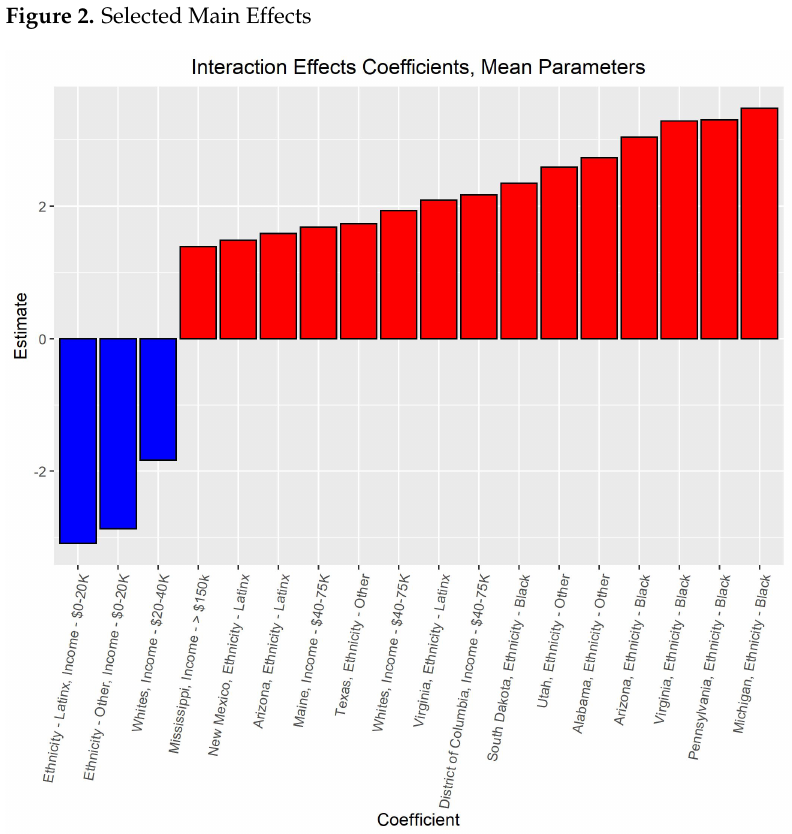
Figure 2. Selected Main Effects